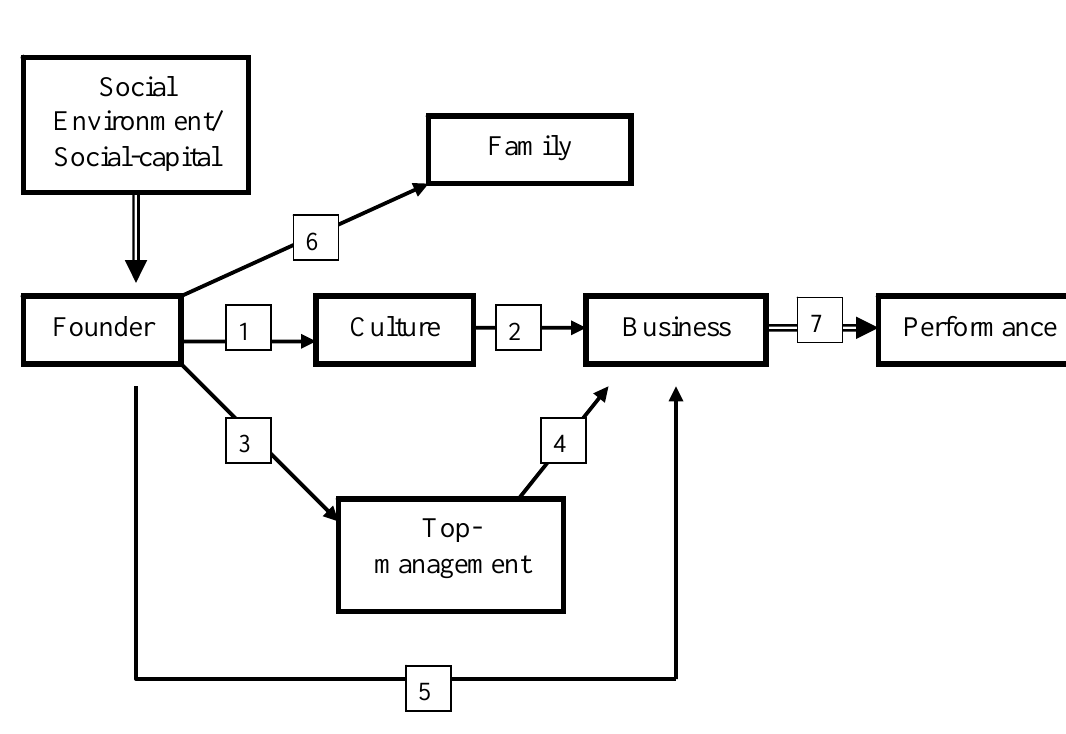
Figure 3: Creation and transmission of familiness in stage one – founder-capital